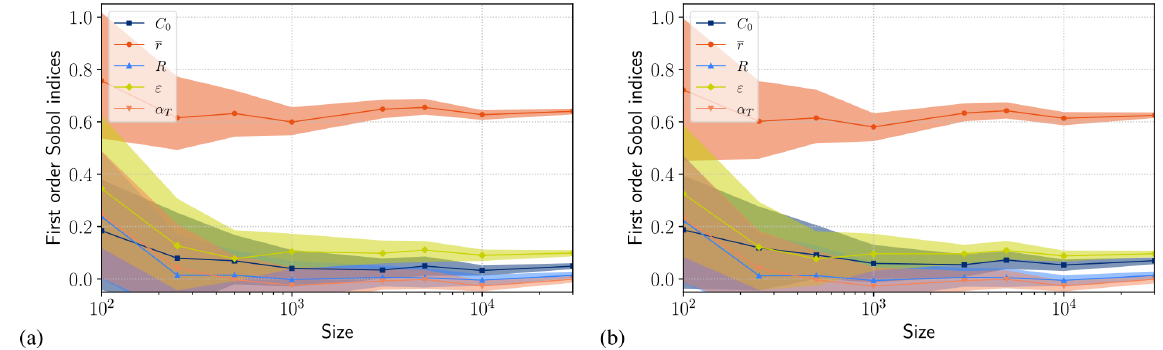
Figure C2. First-order Sobol index convergence for case 1 for temperature (a) and frazil (b) .